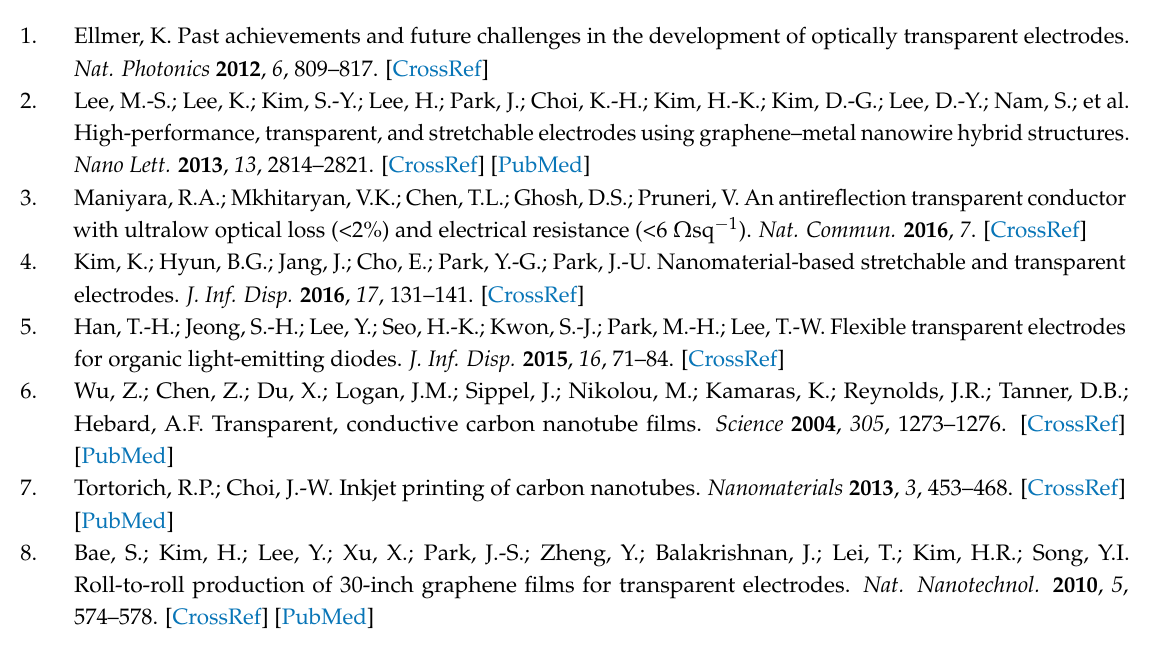
Figure S1: (a) Cross-sectional SEM image of colloidal silica layer after drying; (b) SEM image of the cracked template fabricated by colloidal silica and the substrate surface after removal of the cracked template using ultrasonication, Figure S2: OM images of the fabricated NM using different spin-coating speeds: (a) 1000; (b) 2000; (c) 3000; (d) 4000; (e) 5000; (f) 6000; (g) 7000; and (h) 8000 rpm, Figure S3: (a) Optical transparency in the visible region and (b) sheet resistance of the fabricated MMS using different drying